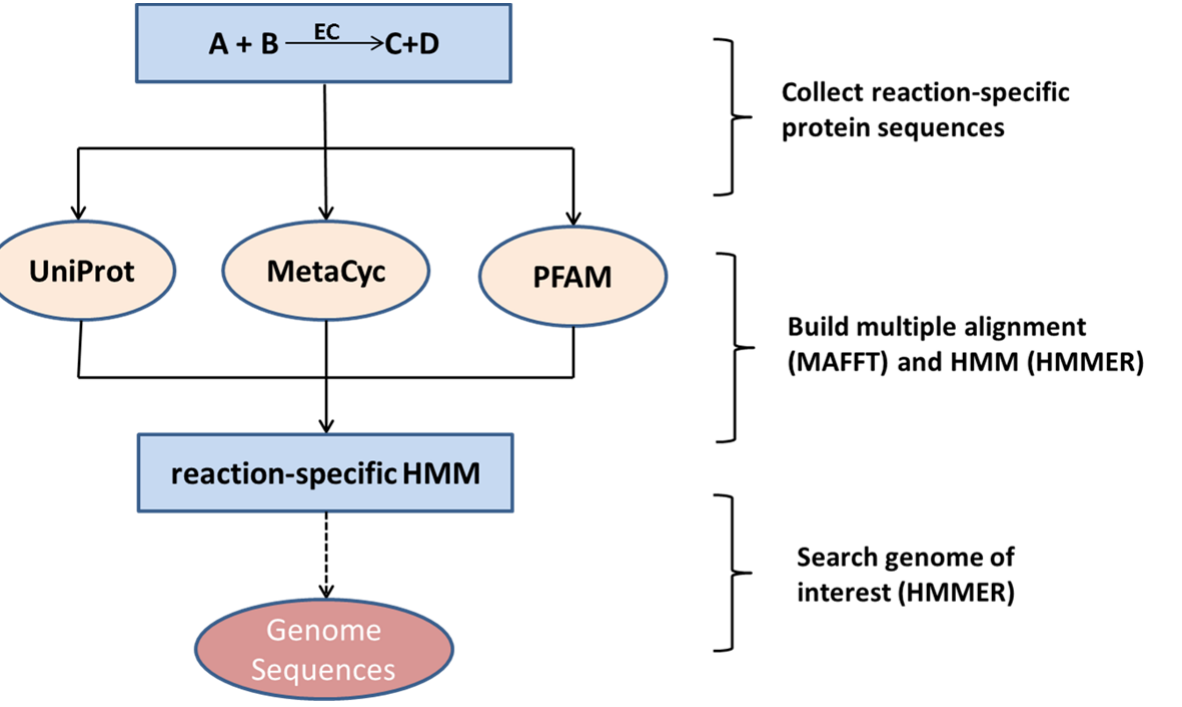
Figure 1. Enzyme annotation workflow applied in this study. For every reaction, enzyme sequences were extracted from databases and used to build reaction-specific and species- independent profile hidden Markov models (HMMs). Using the HMMER software, these reaction HMMs are then used to scan the organism’s protein sequence set resulting in E- values that reflect the probability that a particular protein acts as an enzyme and catalyzes the reaction that is captured by the specific HMM